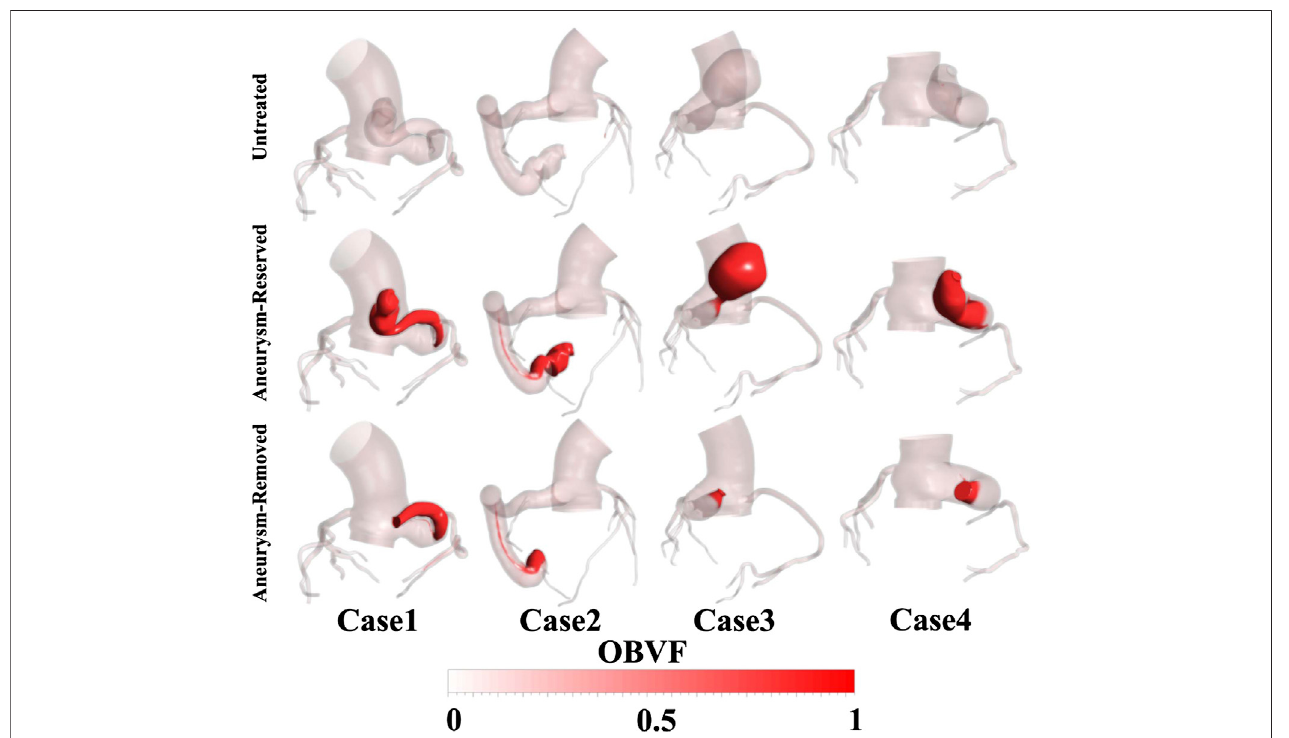
FIGURE 6 | The OBVFs of all models, with the red color representing the blood